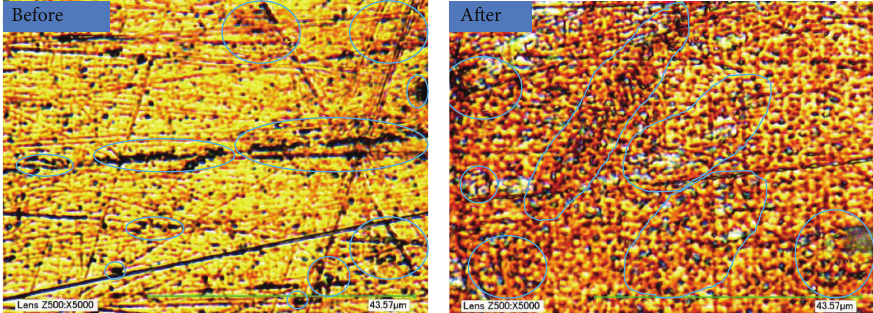
Figure 8: Optical microscopy images of alloy 110 copper before and after (112-hour) test with (reference fluid, without nanoparticles) 50/50% ethylene glycol/water (magnification: 5000x). Preexisting pitting and seemingly clustered ones after treatment are circled.